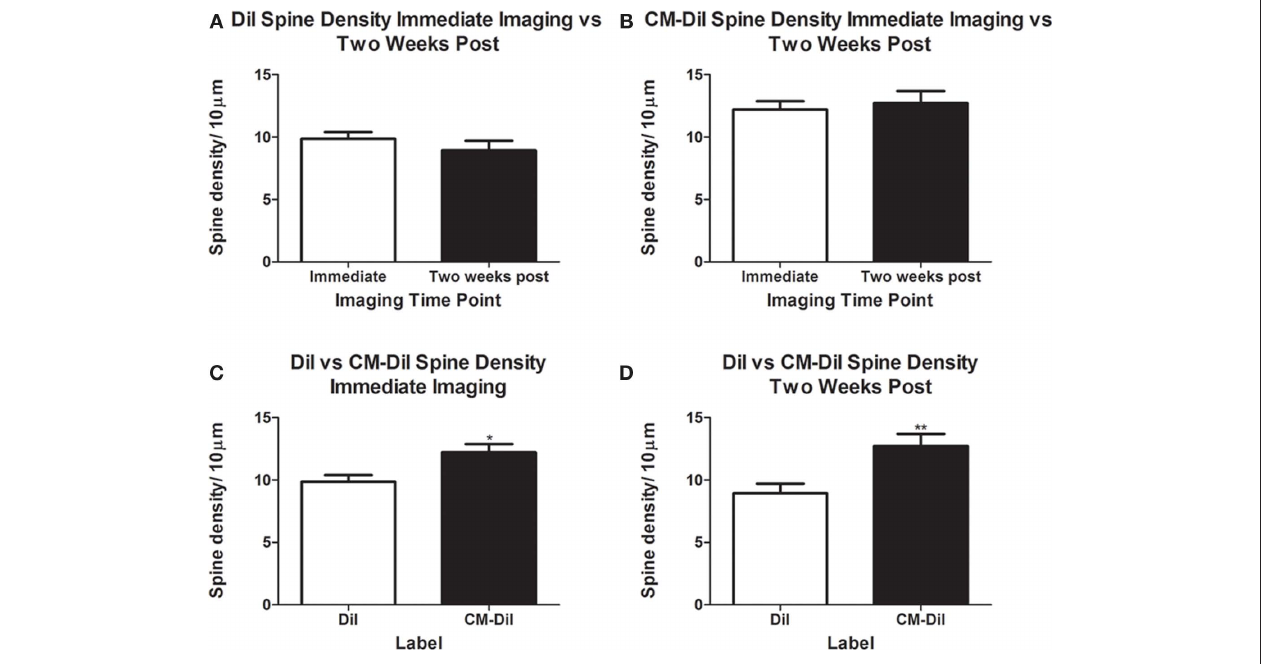
CM-DiI treated tissues when imaged either immediately or 2 weeks following mounting. (C,D) CM-DiI treated tissues yielded significantly higher spine densities when compared to DiI treated tissues at both immediate imaging (* p < 0.05) and imaging 2 weeks following mounting (** p <